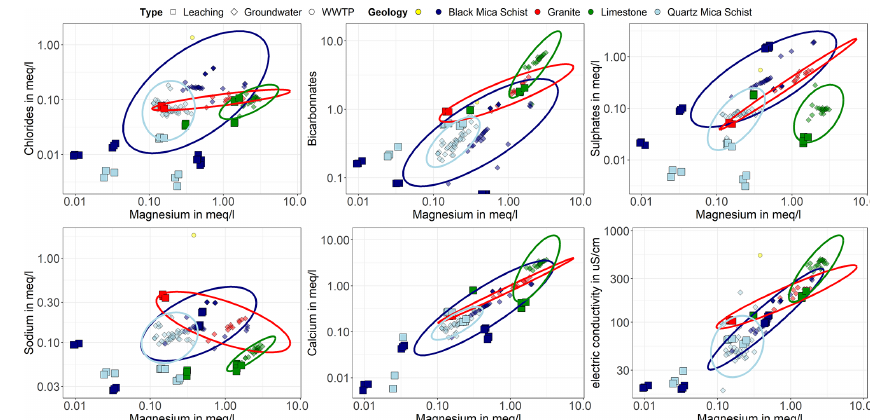
Figure 6. Bivariate solute–solute diagrams of the leachate result with the groundwater sample.